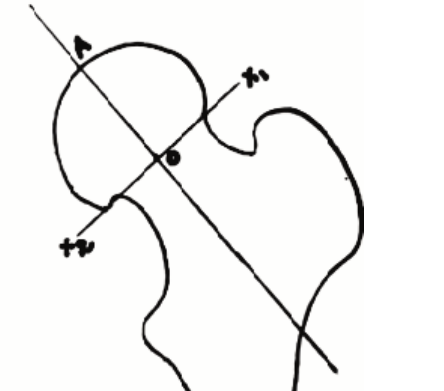
Position of lag screw in femoral head Fig. 3: